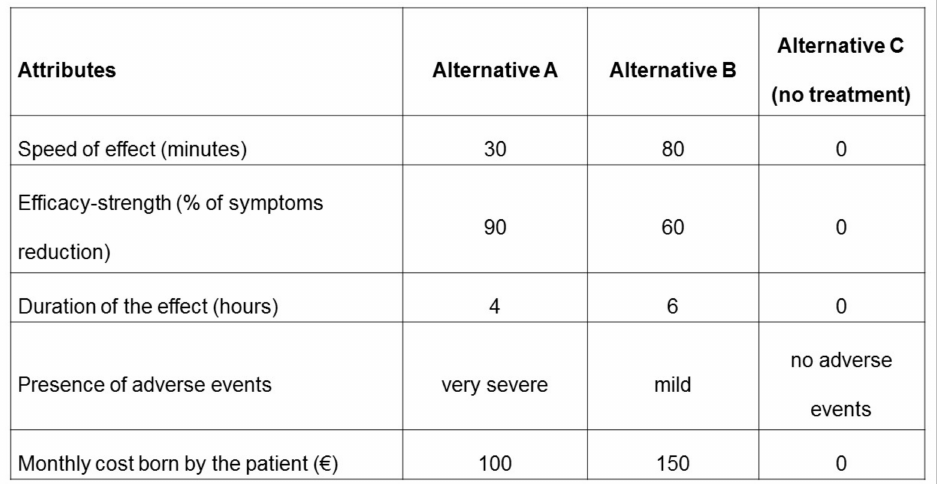
Figure 1. Example of choice